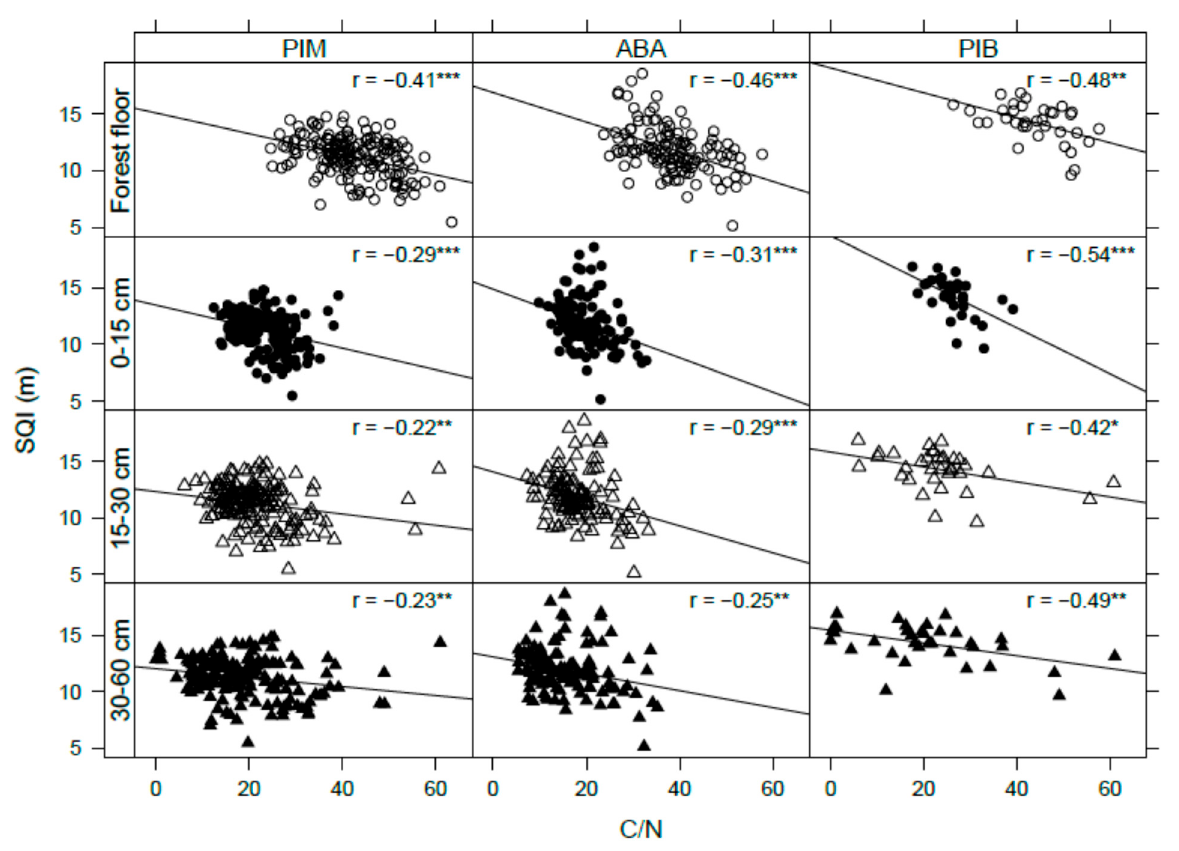
Figure 5. Relationship between site quality index (SQI, height, in m at age 50 years) and the C/N ratio in the forest floor and at various soil depths for Picea mariana (PIM), Abies balsamea (ABA), and Pinus banksiana (PIB). Asterisks indicate significant values of r: * p ≤ 0.05, ** p ≤ 0.01, *** p ≤ 0.001.